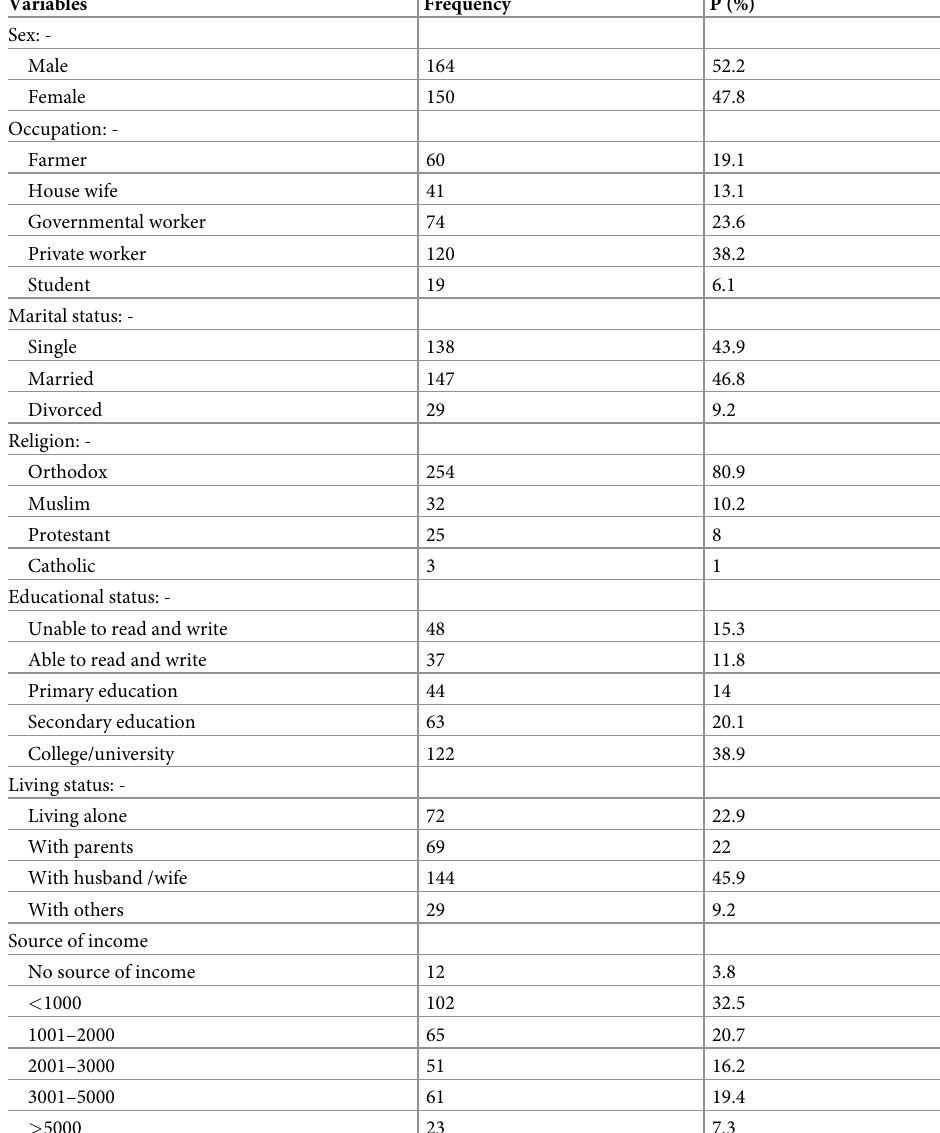
Table 1. Socio-demographic characteristics of the study participants (n =